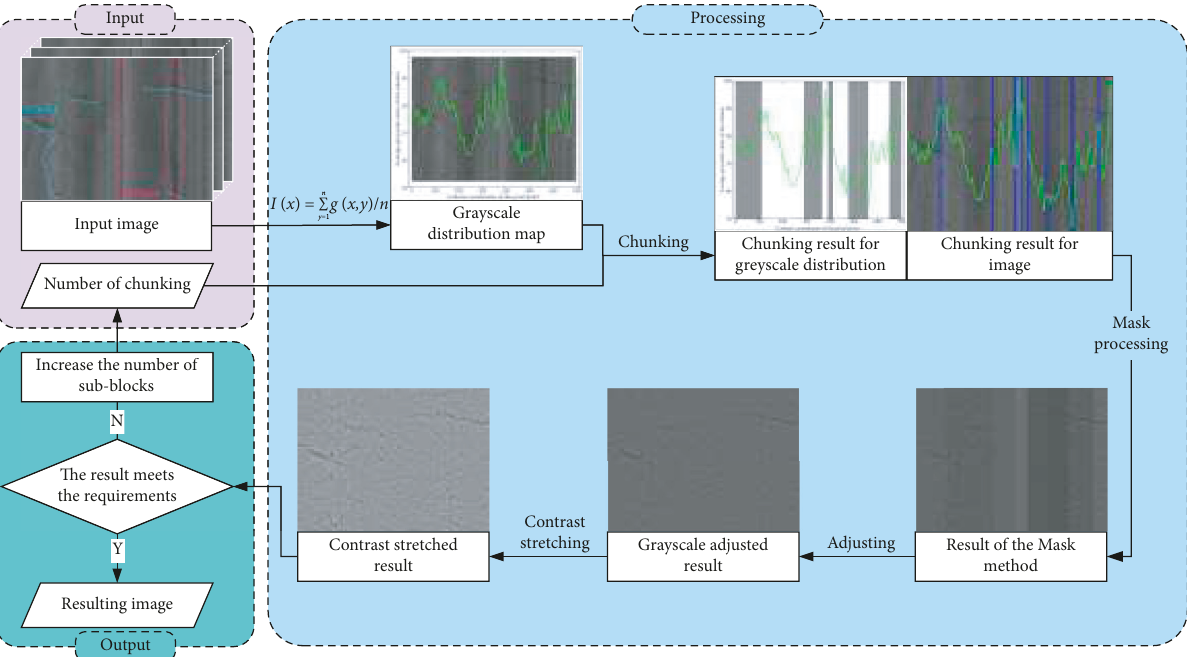
Figure 4: The processing flow of the dodging method in this study.